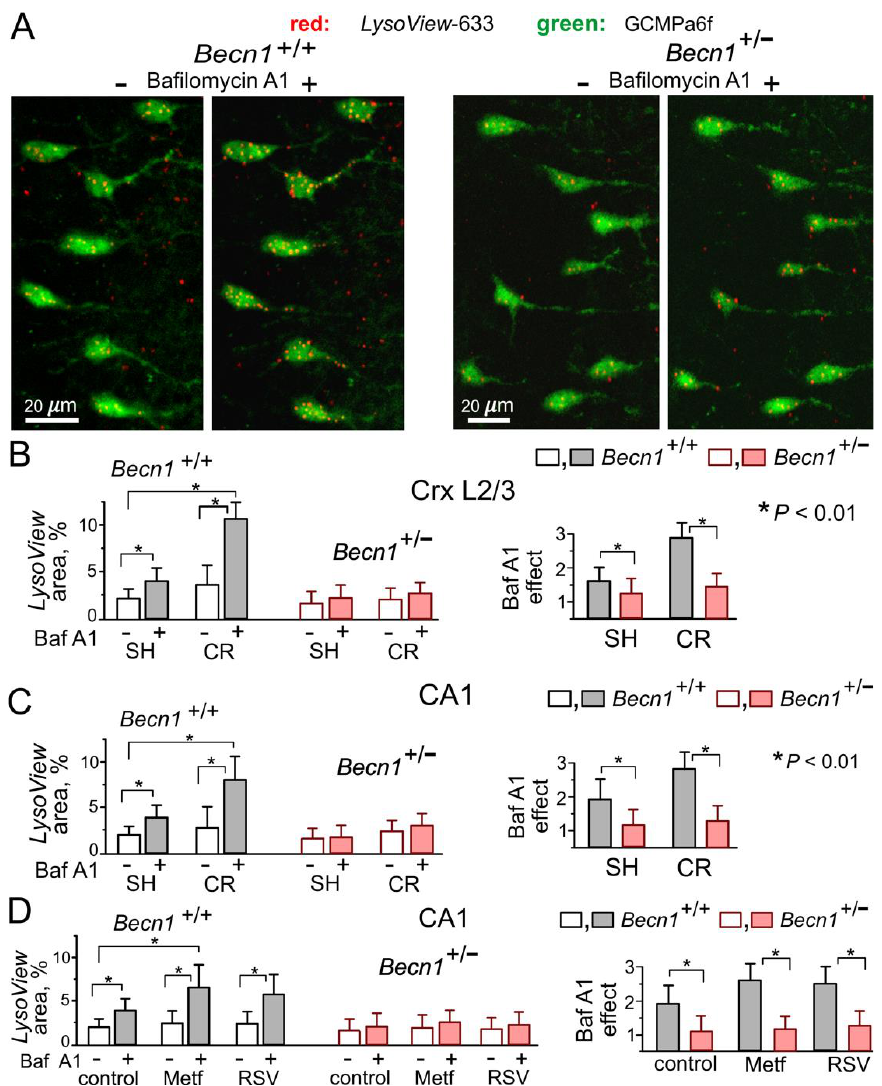
the CR-induced decrease of inhibitory currents was not statistically significant ( p > 0.3 at a statistical power of 0.9). The CR-induced reduction in mIPSCs in the CA1 pyramidal neurons was also Becn1-dependent (Figure 4D).